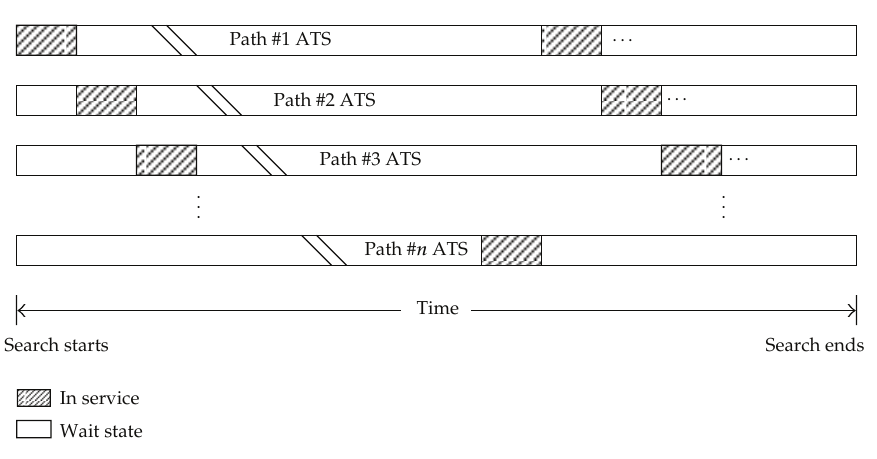
Figure 5: Diagram representing n paths of the